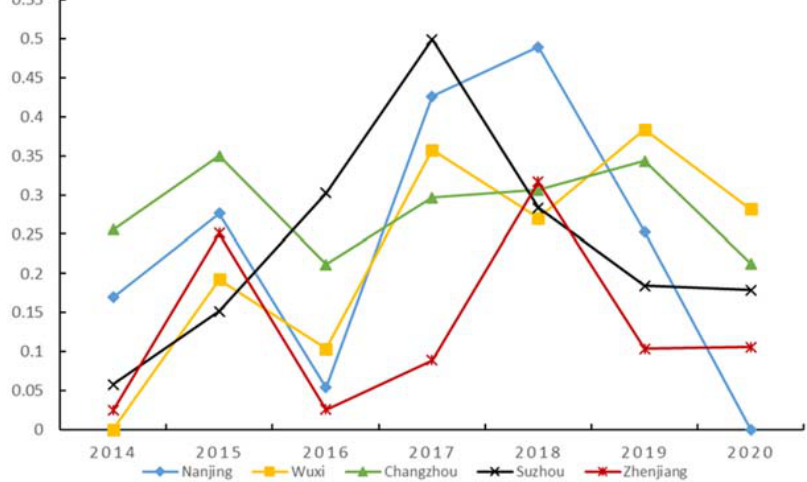
Figure 8. The synergy degrees of WCG systems within cities during 2014–2020.